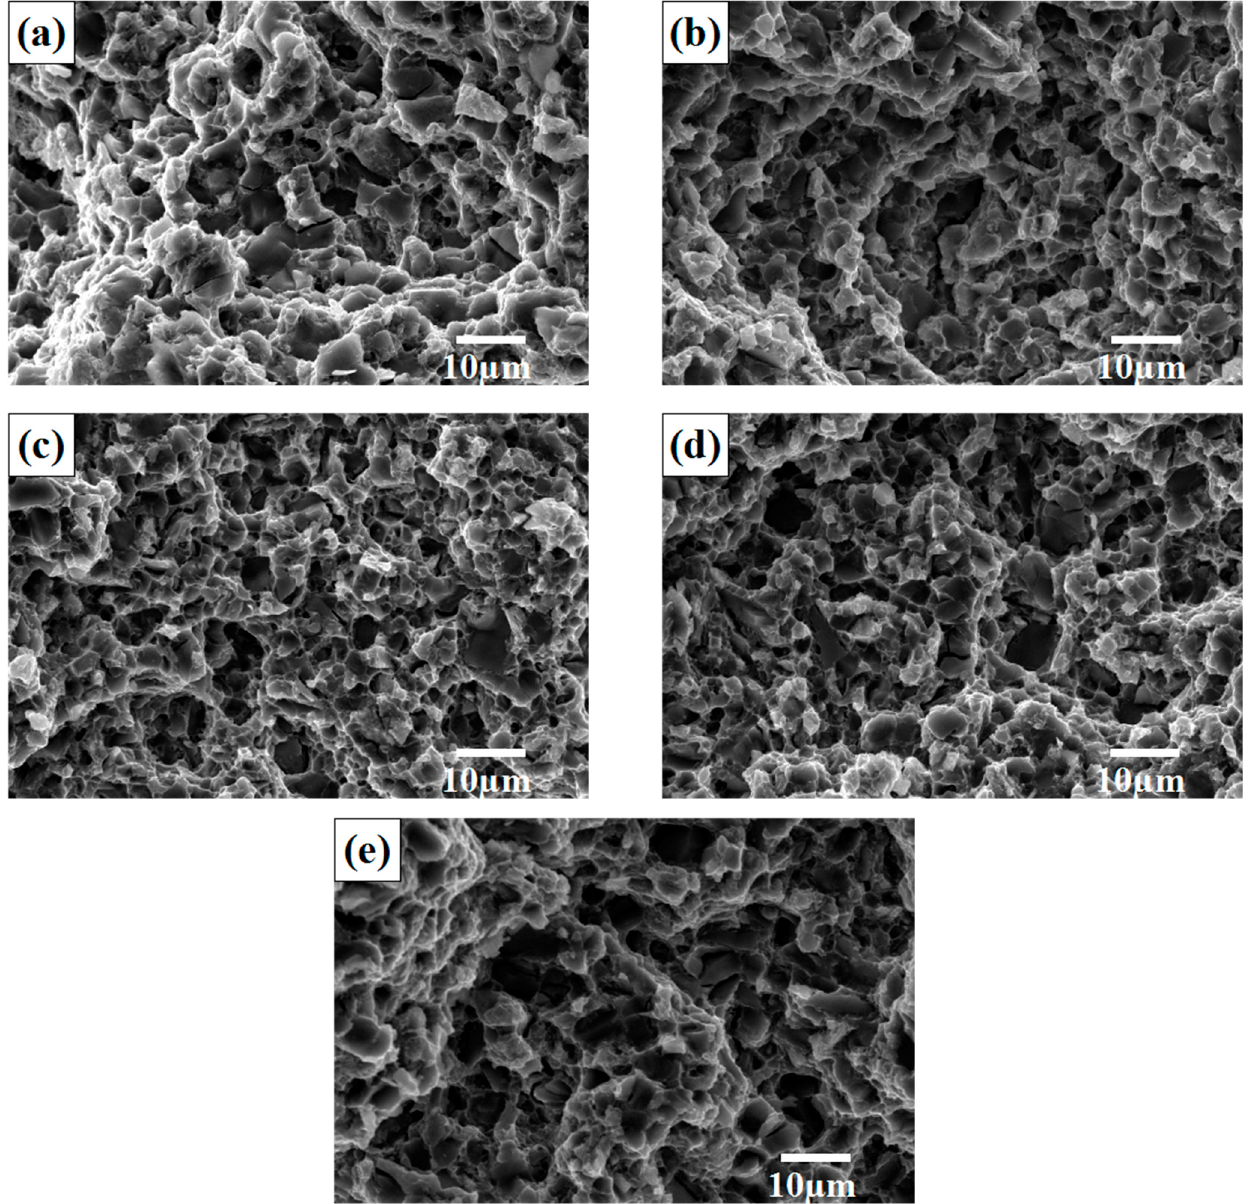
Figure 8. The SEM images of fracture surface of SiCp/Al-Si composites with different volume fraction of CeO 2 : ( a ) 0; ( b ) 0.1%; ( c ) 0.2%; ( d ) 0.3%; ( e ) 0.4%.